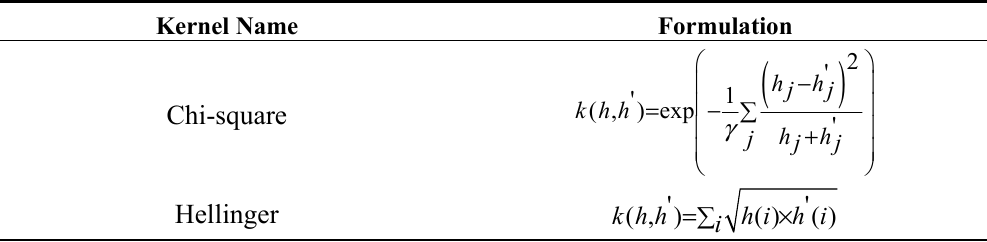
Table 2. Chi-square and Hellinger kernel functions. Here, h and h' are normalized histograms, where h' is derived from h with first order differentiation. k is the kernel function, γ is the regularization coefficient, and i and j corresponds to histogram bin